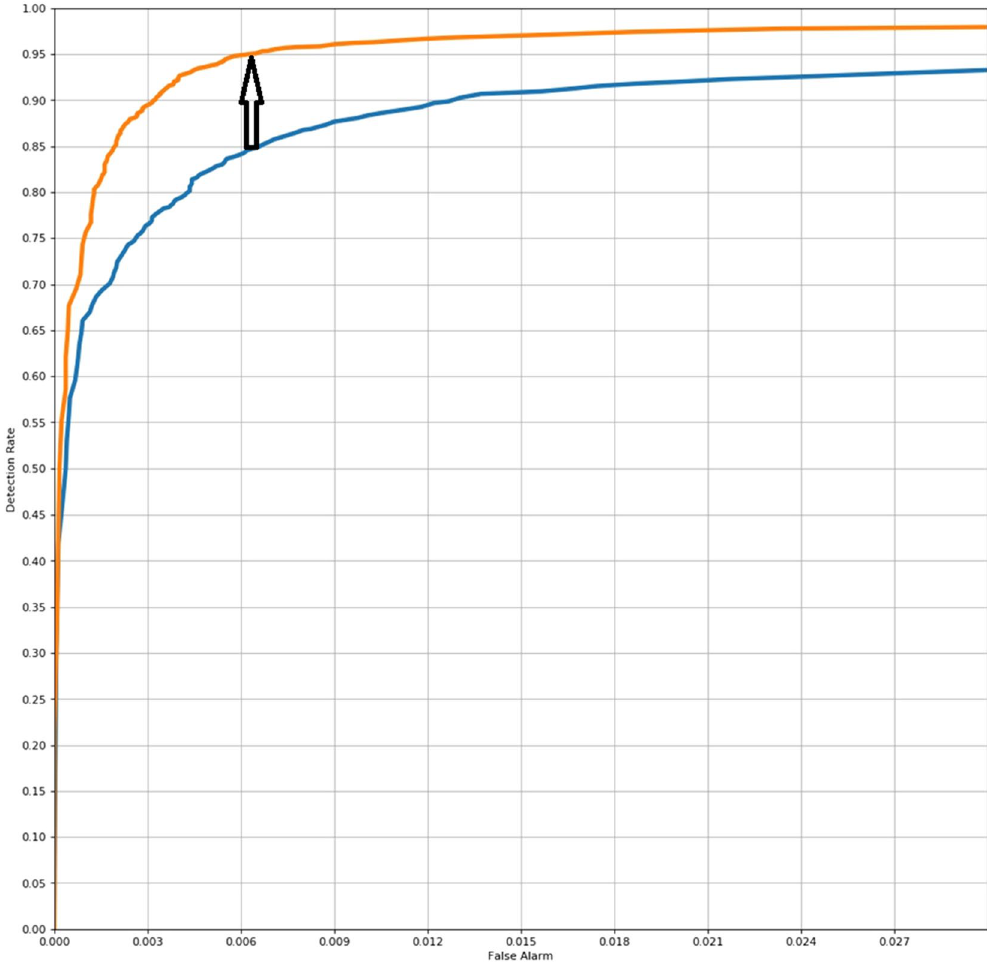
Figure 1. A ROC curves depicting the improvement in the performance of the algorithm after a single iteration. The algorithm’s detection rate is presented in relation to the frequency of a "False alarm" (a false positive result). The blue curve predates the orange curve and is based on less data (one iteration apart). Improvement in performance (for the orange curve) is evident as a higher detection rate for each respective frequency of "False alarm" and is further stressed by the black arrow between the two